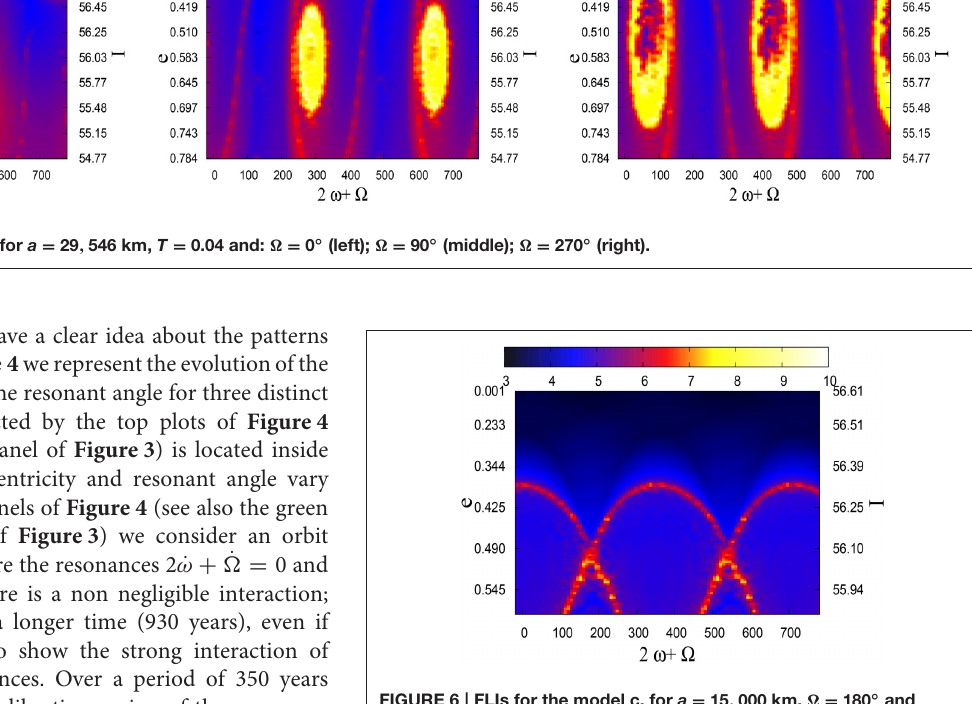
background described by model b, and which does not change significantly in a vicinity of several km from the nominal distance of a 29 , 546 km, one should superimpose the exact = resonances shown in different colors in the right bottom panel of Figure 1 . These resonances are due to the variation of the lunar node, as noted by Ely and Howell (1997), Rosengren et al. (2015a), and their location depends on the value of the semimajor